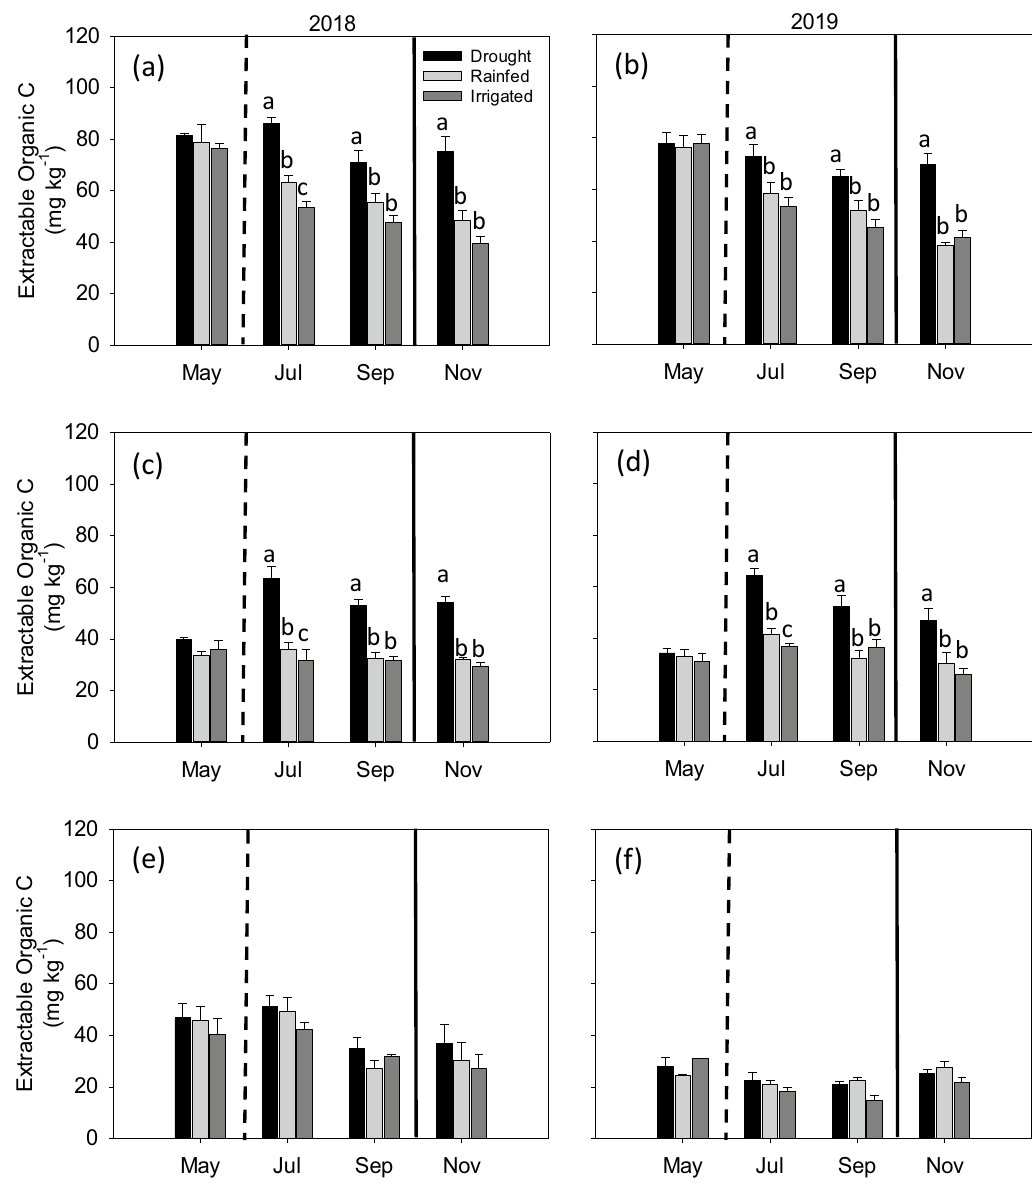
Figure 4. Extractable organic carbon concentrations under drought, rainfed, and irrigated treatments at 0–5 ( a , b ), 5–15 ( c , d ), and 15–30 ( e , f ) cm depths during 2018 and 2019. Different letters represent statistical significance at p ≤ 0.05 at each time point. No letters mean no statistical significance. Error bars represent standard error (n = 3). Sampling in May represents baseline and in November represents post shelter removal. Vertical dashed line represents shelter establishment date and solid line represents shelter removal